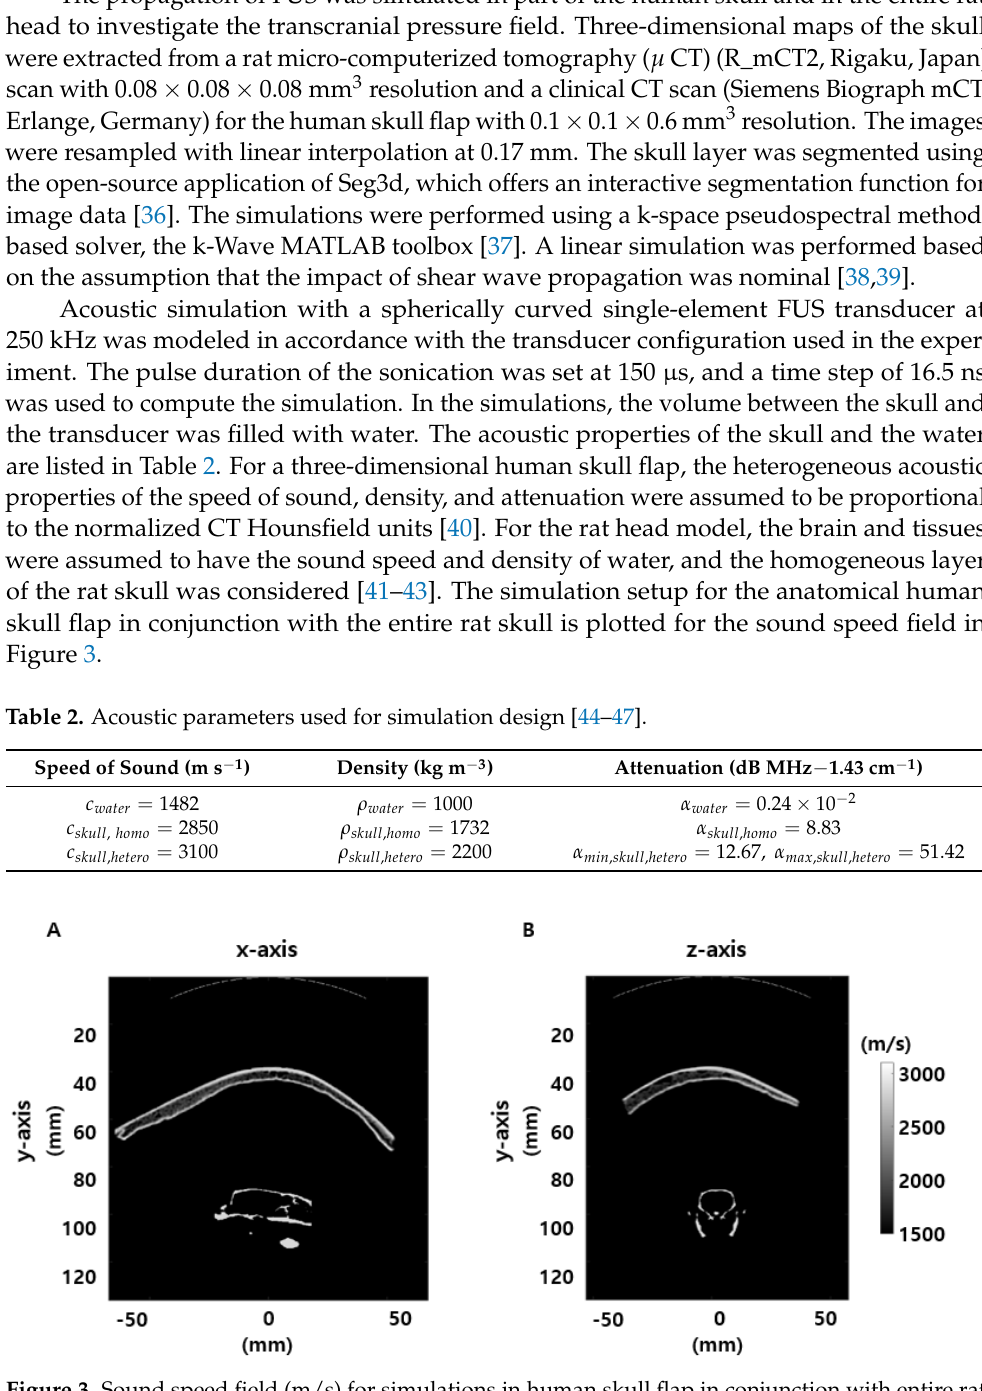
Figure 4. Pulse - echo response of focused ultrasound transducer. ( A ) Time - domain and ( B ) fre- quency spectrum results. 3.2. Ultrasound Acoustic Characteristic Analysis According to Existence of Human Skull Ultrasound parameters for safe BBBD in the free field and human skull were deter- mined based on our previous study using a 1 MHz FUS transducer. First, an ultrasound power of 0.7 MPa using a 1 MHz FUS transducer was measured as 0.09 W. When 300